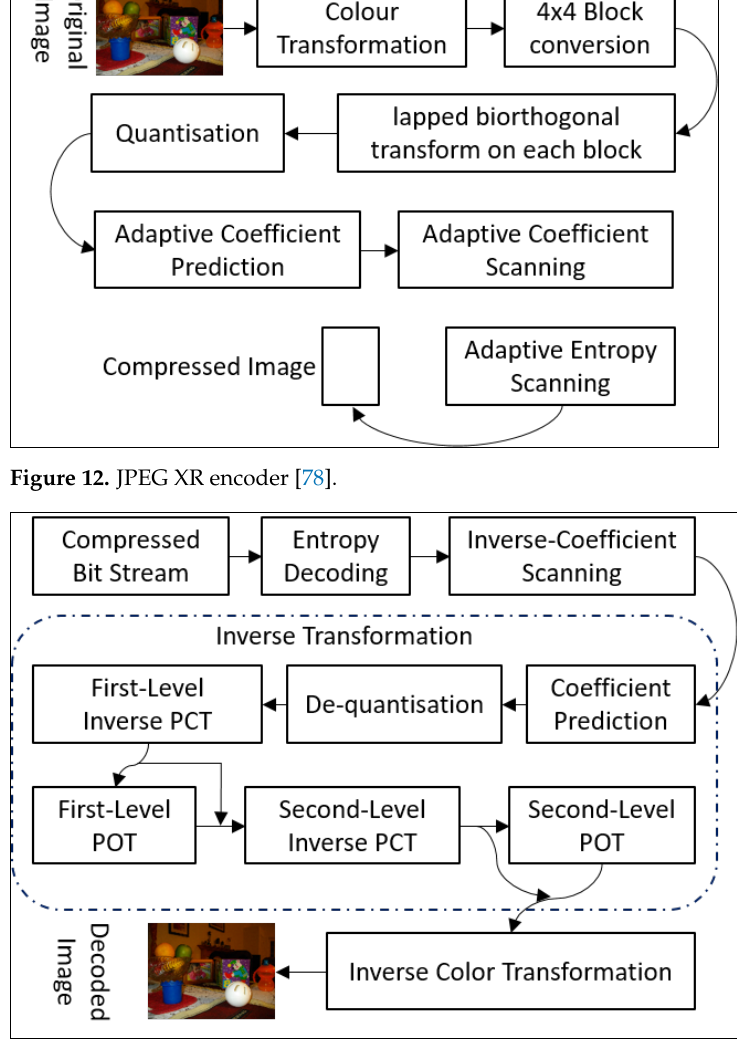
Figure 13. JPEG XR decoder